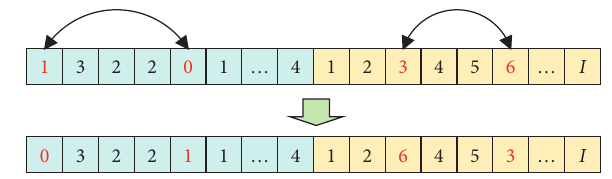
Figure 5: An example of a swap mutation strategy.